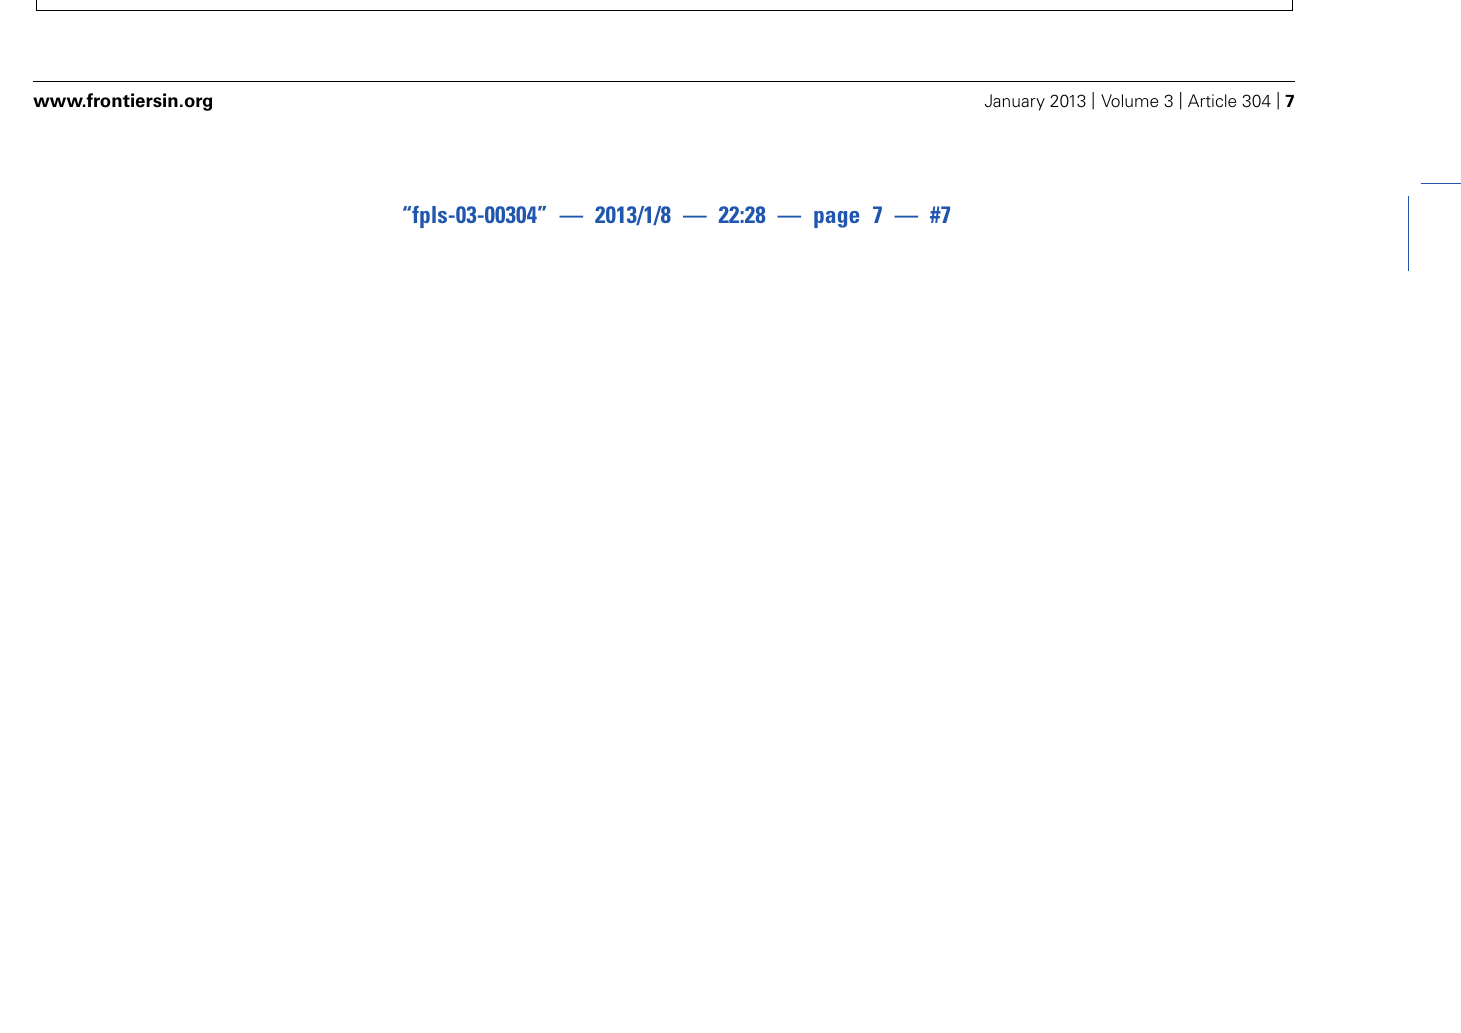
FIGURE 4 |Target genes ofABI4. (A) Genes activated by ABI4 generally contain the CE1-like sequence (CACCG; in blue) identified by Niu etal. (2002). In contrast, repressed genes contain the CE1-like element in the reverse orientation (GCCAC) and overlap with the G-box element (underlined in green; B ).The proposed model of repression by ABI4 is depicted in (C) . Competition for the binding site between ABI4 and GBF